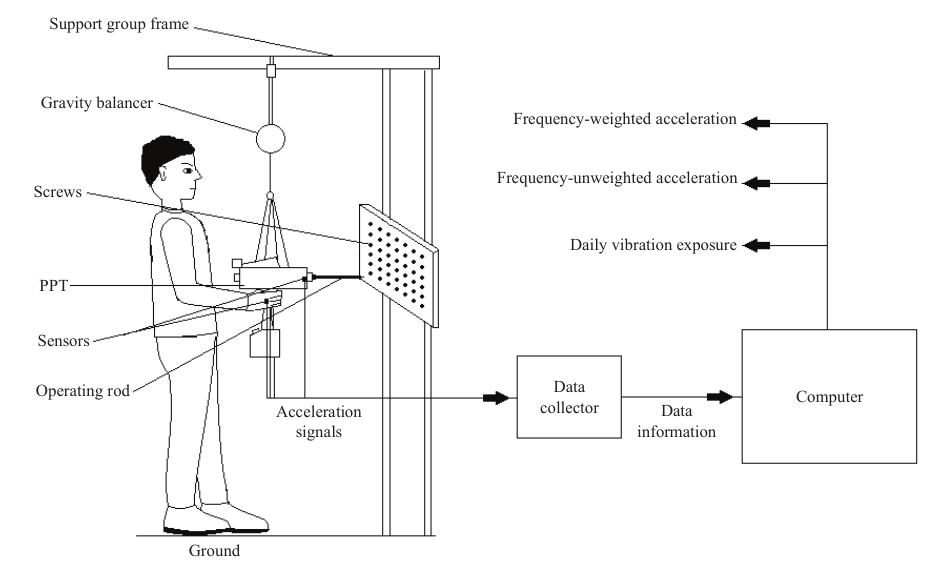
Figure 2. Typical subject posture for measuring biodynamic responses of the human hand.